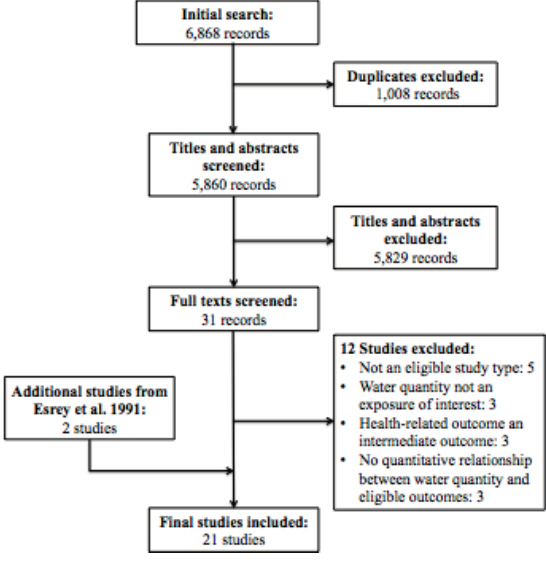
Figure 1. Study Flow